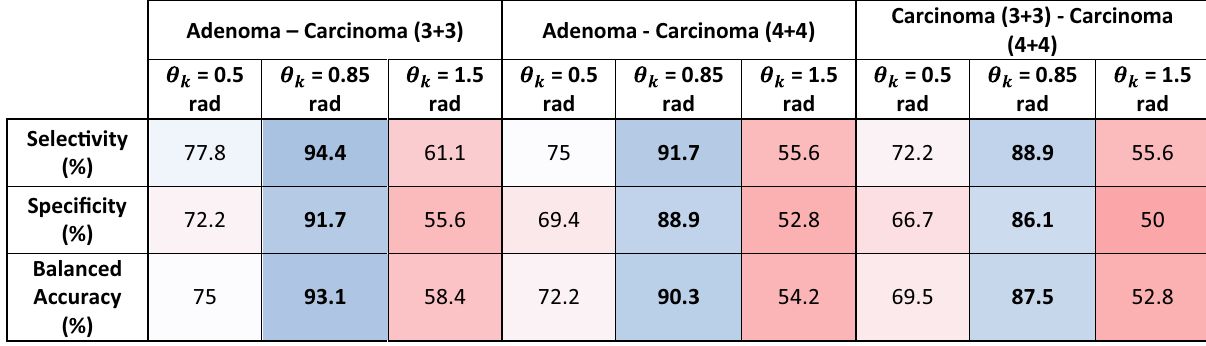
Table 3. Selectivity, specificity, and balanced accuracy of the diagnostic power of the 3D Mueller matrix mapping method of native histological sections of benign and malignant prostate tumours in the layered phase sections corresponding to θ k = 0.5rad , θ k = 0.85rad , and θ k = 1.5rad